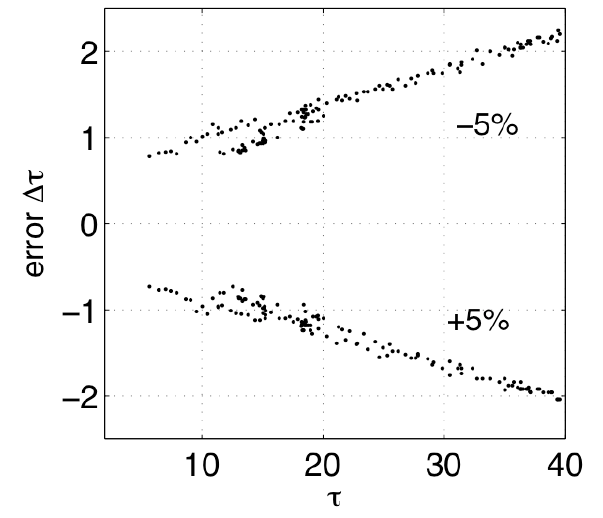
Figure 4: Error in τ associated with a 5 % uncertainty in the pyranometer measurements. 932 Fig. 4. Error in τ associated with a 5% uncertainty in the pyranome- ter